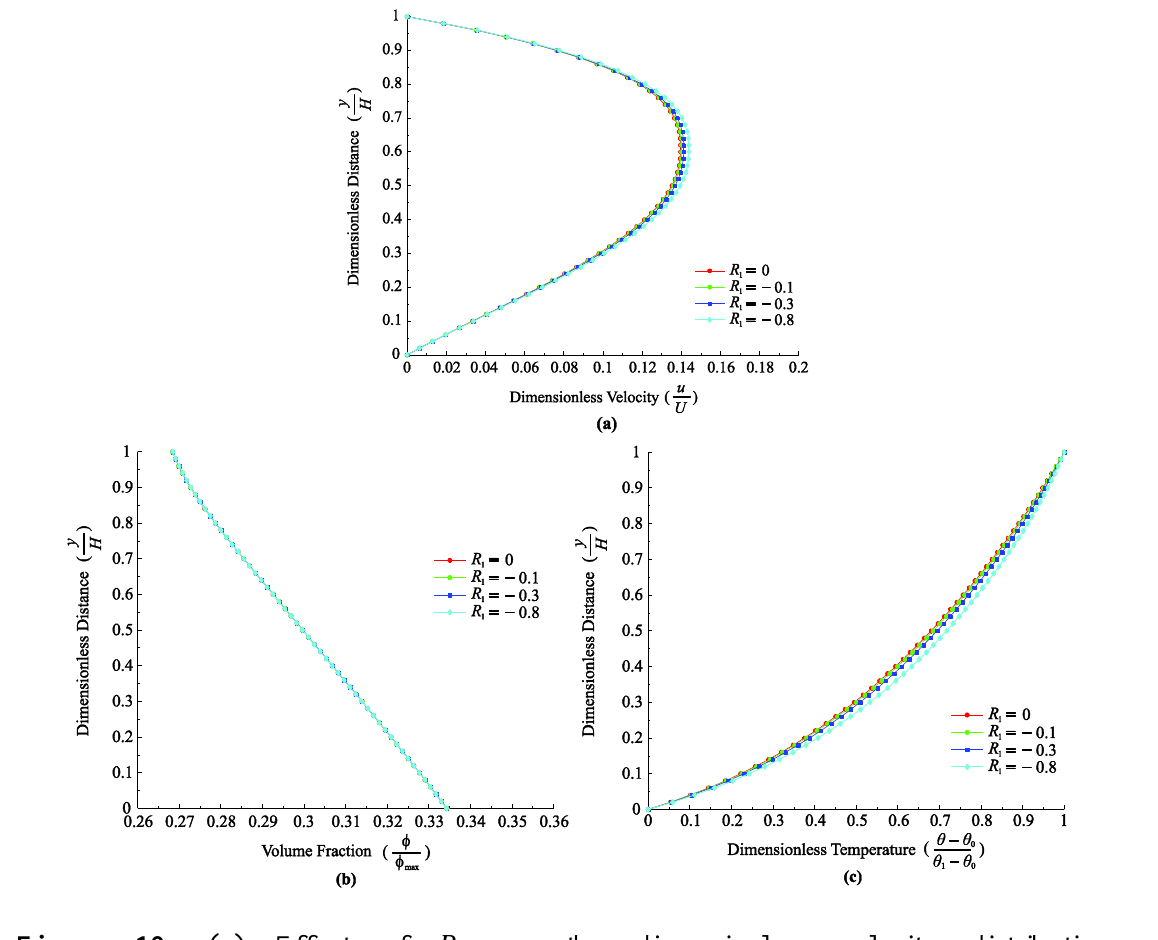
Figure 10. ( a ) Effect of 𝑅 on the dimensionless velocity distribution. 1 ( b ) Effect of 𝑅 on the volume fraction distribution. ( c ) Effect of 𝑅 on the temperature 1 1 distribution. 𝑚 = −0.3, 𝑀 = 1, 𝐵 = −2, 𝐵 = 0.01, 𝐵 = 10, 𝐵 = 0.1, 𝑇 = 1.5, 𝑁 = 0.3, 1 2 3 4 𝑅 ~𝑅 = 0, 𝑅 = 2.3, 𝑅 = 𝑅 = 0 2 4 5 6 7